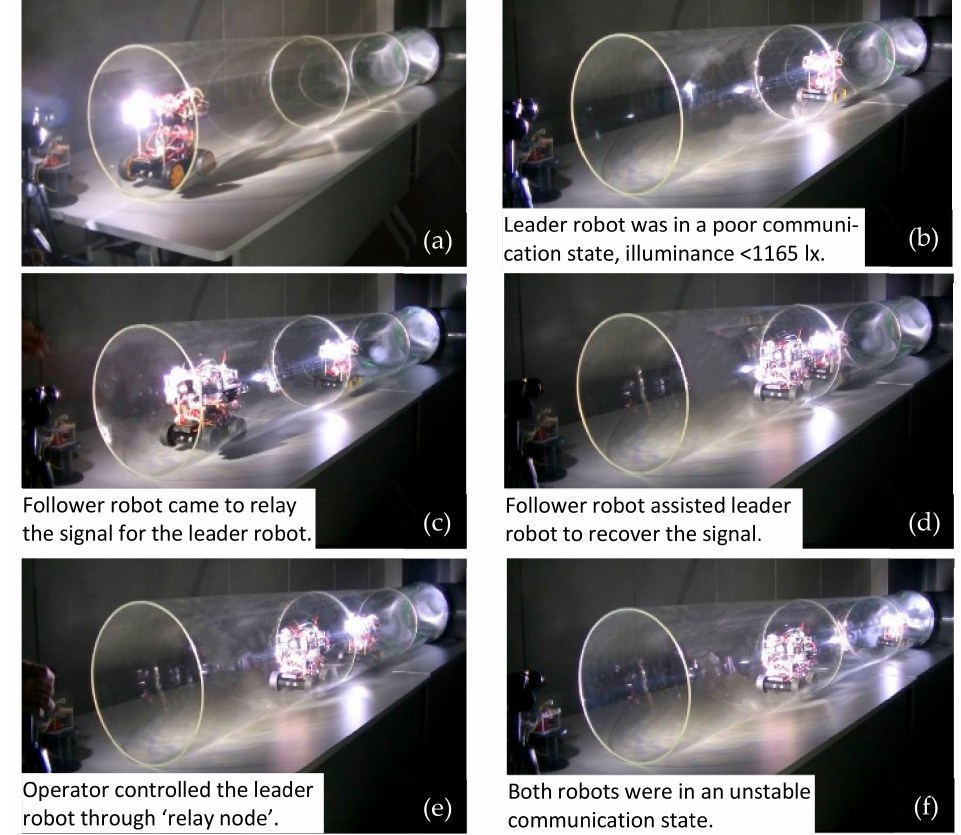
Figure 15. Coordinated movement of Robot Chain System (RCS) in transparent